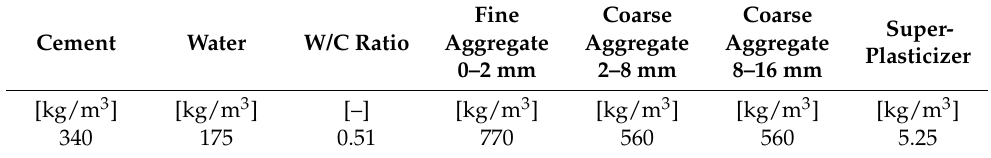
Table 2. Concrete mix